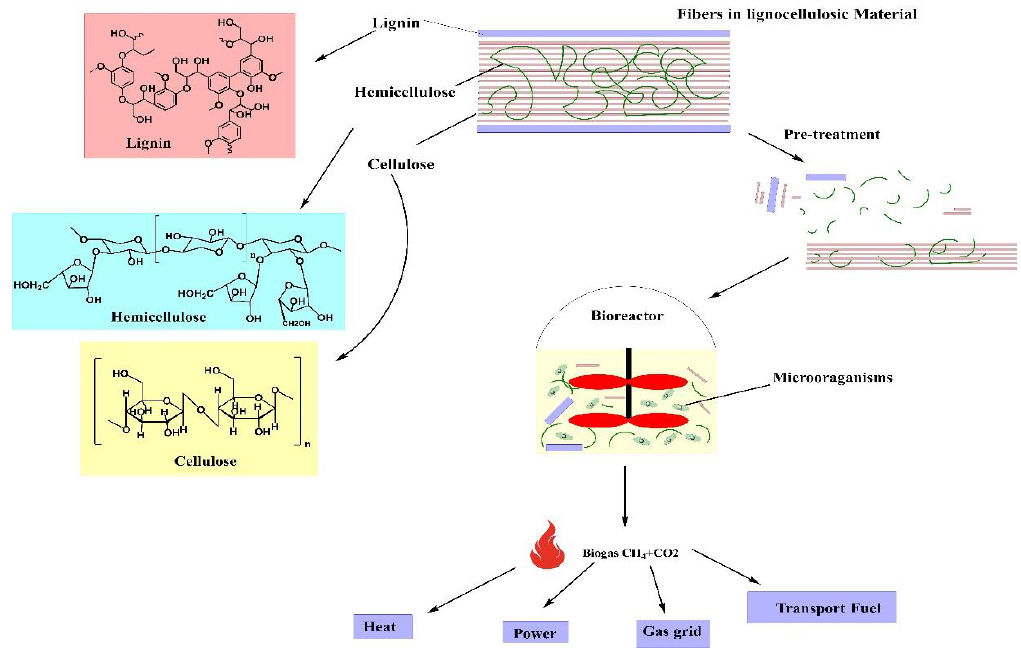
Figure 3. Effect of pretreatment on lignocellulosic materials and their conversion during anaerobic digestion. Table 2. Innovative pretreatment techniques to enhance degradation of lignocellulosic materials under anaerobic digestion.